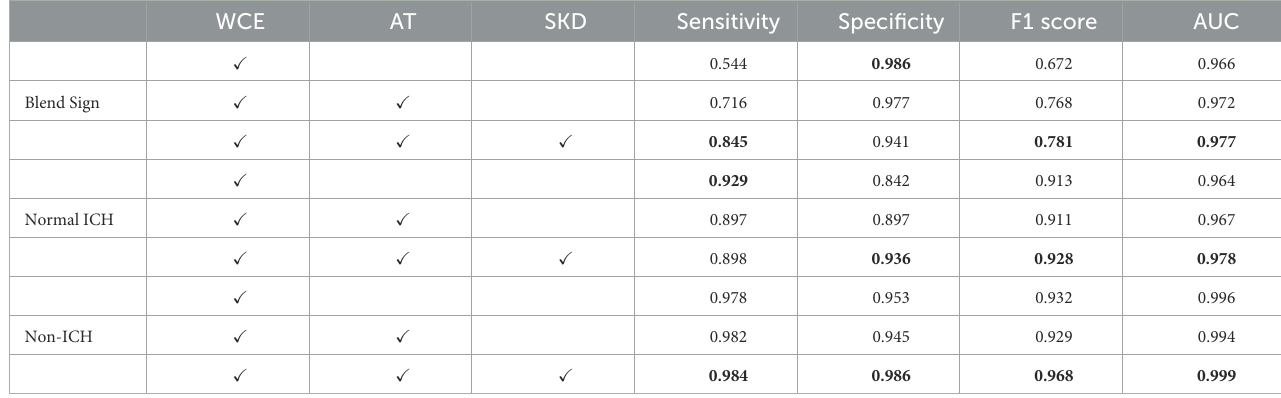
TABLE 3 Performance of the automated detection algorithm on our dataset with ResNet-50 as the backbone. WCE AT SKD